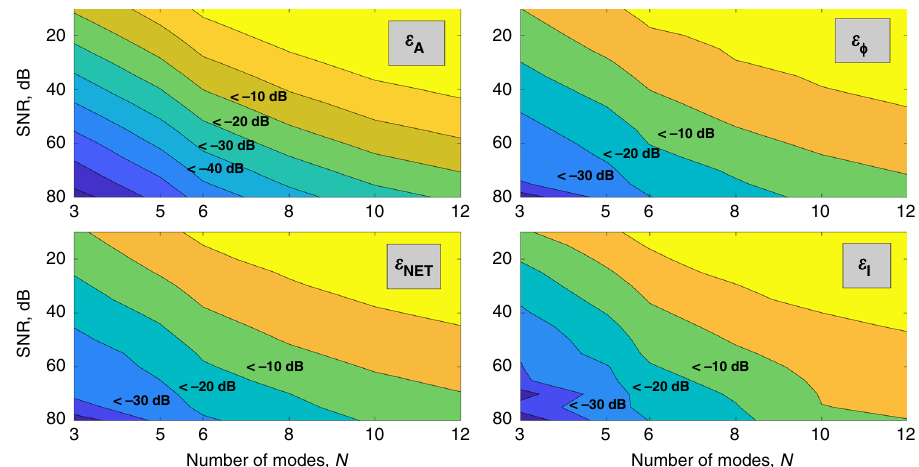
Fig. 4 Decomposition errors depending on noise level and number of modes. Decomposition errors depending on SNR and number of modes for 100 × 100 input image: a amplitude error, b phase error, c net error, and d intensity error. Horizontal axes correspond to the number of modes and vertical axes correspond to SNR in dB. Decomposition error values are color-coded, regions with an error value less than a certain value are labeled on the graphs. Here ε — amplitude error, ε φ — phase error, ε — total error, and ε — intensity error. Source data are provided as a Source Data fi le. A NET I